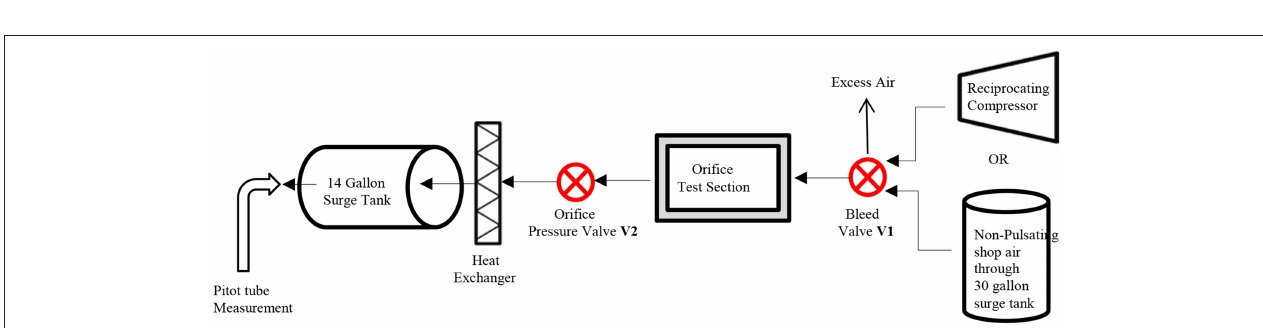
FIGURE 1 | The schematic on the top shows the apparatus used to generate the engine data, details available in Brahma et al. (2014). Bottom plots: Comparison of engine differential pressure pulses (bottom-right) with those generated by the pulsating apparatus (bottom-left). Each engine cycle produced four pulses that were different from each other. Possible reasons are differences in combustion and different interference patterns dependent on the geometry of the exhaust manifold. The pulsating apparatus used a single cylinder compressor to produce consistent pulsations.